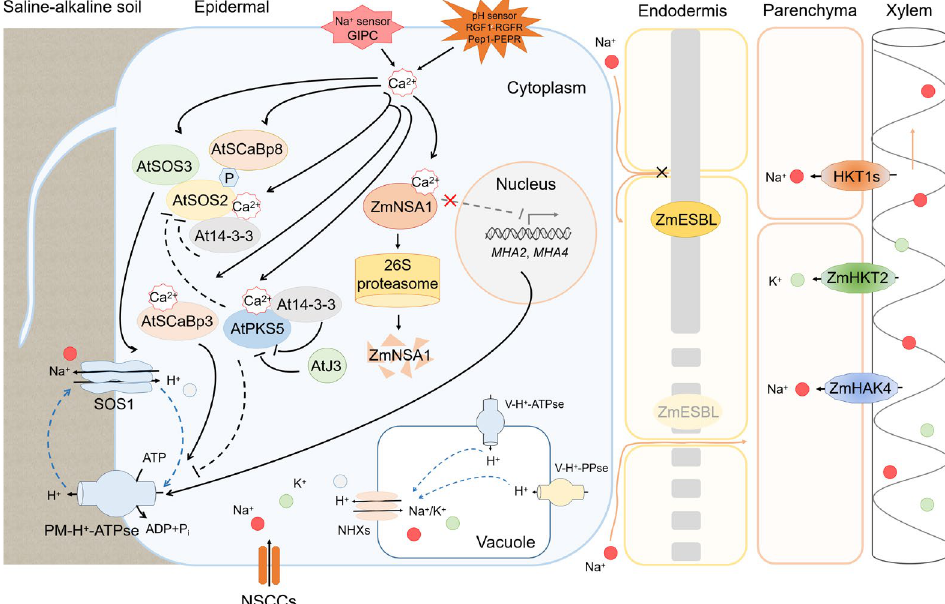
Figure 2. The mechanism model of ion (Na + and K + ) homeostasis and pH stability mediated by the combination of ion transporters and H + -ATPase. Na + enters into the root cells via NSCCs. The change in Na + and pH values was sensed by Na + sensor GIPC or pH sensor and induced the change of cytoplastic Ca 2+ , which then binds to Ca 2+ -binding protein (SOS3, SCaBP8, SCaBP3 and ZmNSA1), triggers SOS pathway to promote Na + exclusion. At the same time, J3 was activated by PKS5 to release the inhibition of AHA2, inducing SCaBP3 dissociation from AHA2, thus promoting PM H + -ATPase activity. In addition, Ca 2+ binds to ZmNSA1 and triggers its degradation by the 26S proteasome, which induces the expression of MHAs and increases the activity of PM H + -ATPase. These pathways collectively mediate Na + efflux under saline-alkali stress. NHXs, located in tonoplast, transport Na + or K + into vacuole dependent on the H + gradient created by V-H + -ATPase and V- H + -PPase, and regulate the excessive Na + compartmentalization, Na + /K + balance and pH stability in cytoplasm. ZmESBL, located in Casparian strips, functions in the formation of CS and prevents excessive Na + across the endodermis. The Na + -selective transporter HKT1 and ZmHAK4 mediate shoot Na + exclusion by retrieving Na + from the xylem vessels, while K + -preferring transporter HKT2 transports K + from xylem sap to parenchyma cells, maintaining the lower Na + /K + ratio under saline-alkali stress. NSCCs: non-selective cation